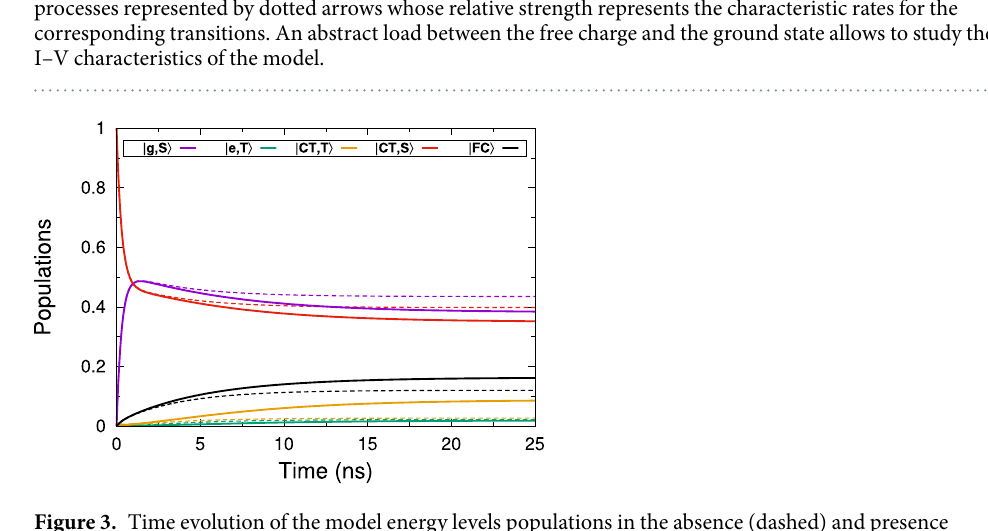
Figure 3. Time evolution of the model energy levels populations in the absence (dashed) and presence (continuous) of a 25 T magnetic field. We have chosen a small triplet CT to triplet exciton decay rate of 2 ns to enhance the action of the magnetic field for displaying purposes. We will show in the next section how a faster rate also produces a noticeable photocurrent increase in the presence of a magnetic field. Geminate recombination and free charge generation both have a 1 ns rate, while non-geminate recombination is 1.5 ns and triplet fusion is 0.5 ns. Both triplet CT and FC populations at the steady state increase in the presence of a magnetic field, as